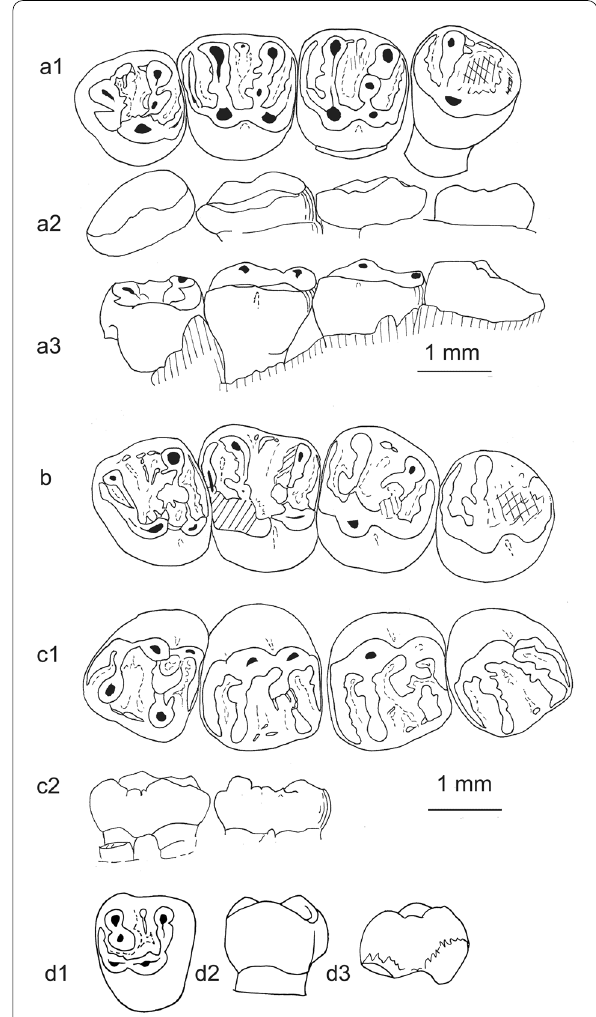
Fig. 5 Upper Teeth of Protadelomys cartieri (Stehlin & Schaub, 1951), from Egerkingen (Swiss Jura). a Ek 123, left upper tooth row, P4– M1–3; a1, occlusal view; a2, buccal aspect; a3, id., lingual aspect. b Ek 245, left upper tooth row, P4–M1–3, occlusal view; c Ek 245, right upper tooth row, P4–M1–3; c1, occlusal view; c2, buccal aspect of P4–M1. d Ek 48, right upper P4; d1, occlusal view; d2: lingual aspect; d3: buccal aspect. Scale bar: 1